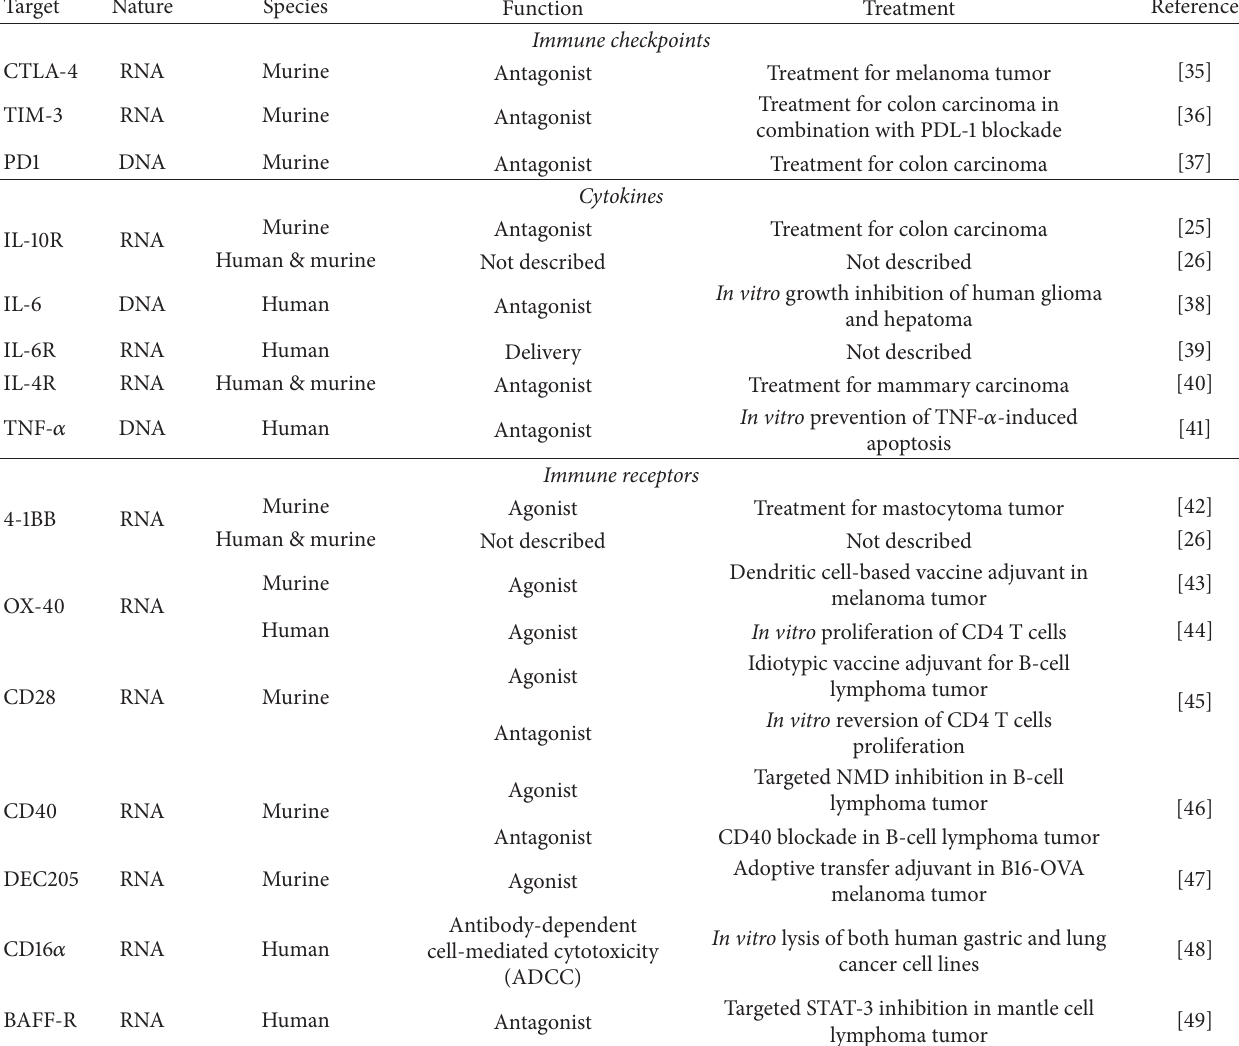
Table 1: Summary of agonistic and antagonistic aptamers used in cancer